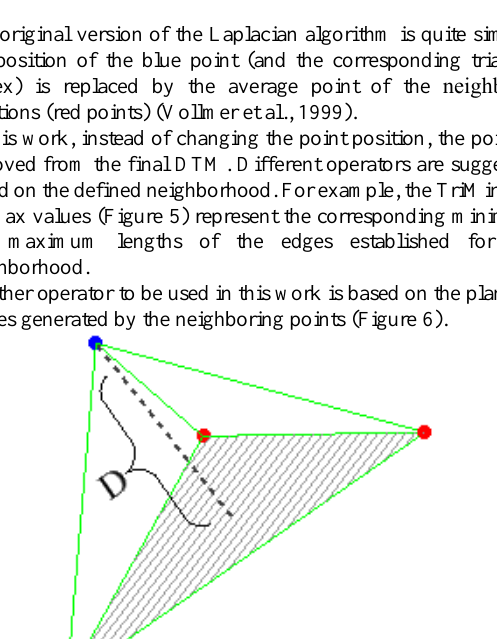
Figure 5. Neighborhood relation through the shared edges.